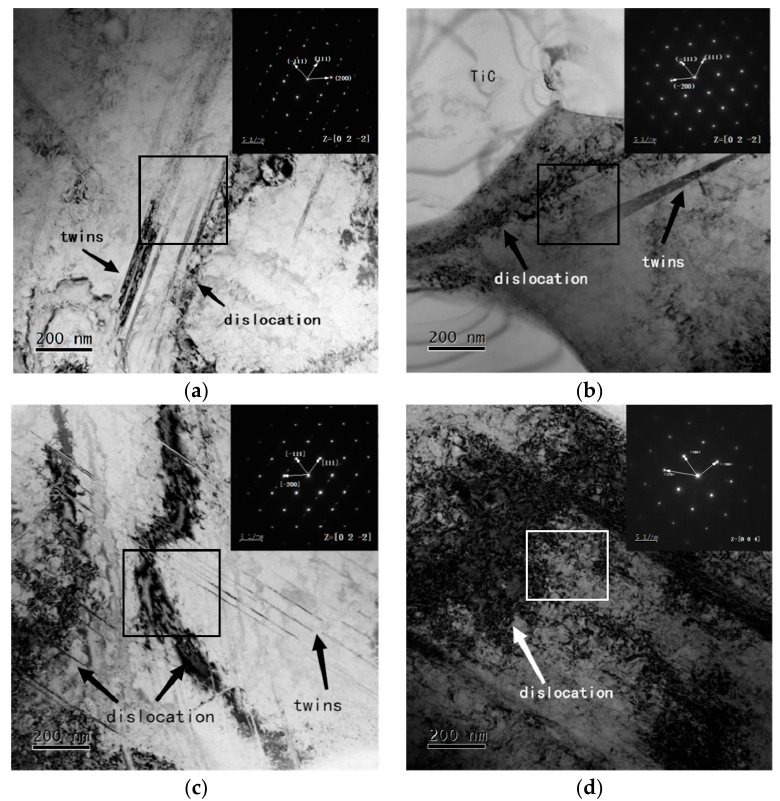
Figure 7. TEM micrographs with different heat input: ( a ) sintered; ( b ) 3.4 KJ/cm; ( c ) 6.2 KJ/cm; ( d ) 7.9 KJ/cm.